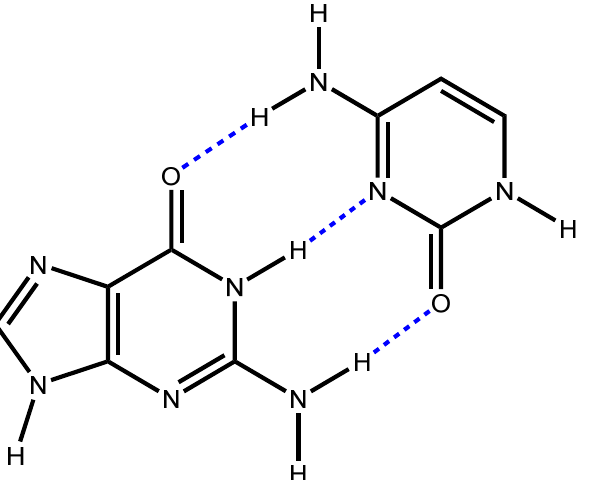
Figure 1. Guanine (G) cytosine (C) pair structure. The intermolecular hydrogen-bonds are displayed in blue.